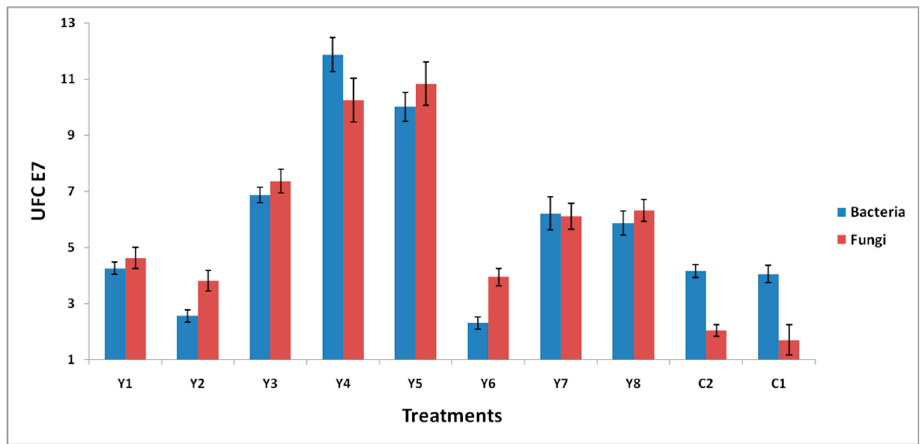
Figure 4. Colony-forming units (CFUs) of fungi and bacteria in the biostimulation system. “I” indicates the standard deviation of the means.